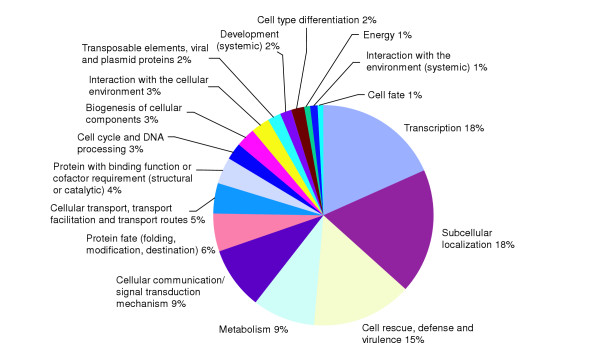
Functional distribution of genes that are differentially regulated in leaves of the five accessions. Fifty-eight genes, identified by one-way ANOVA analysis, were subjected to MIPS functional classification based on their annotations.